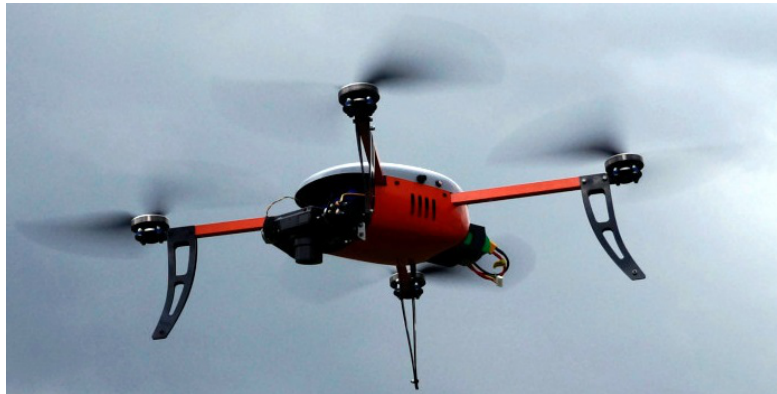
Figure 1. Quadcopter ARAKNOS